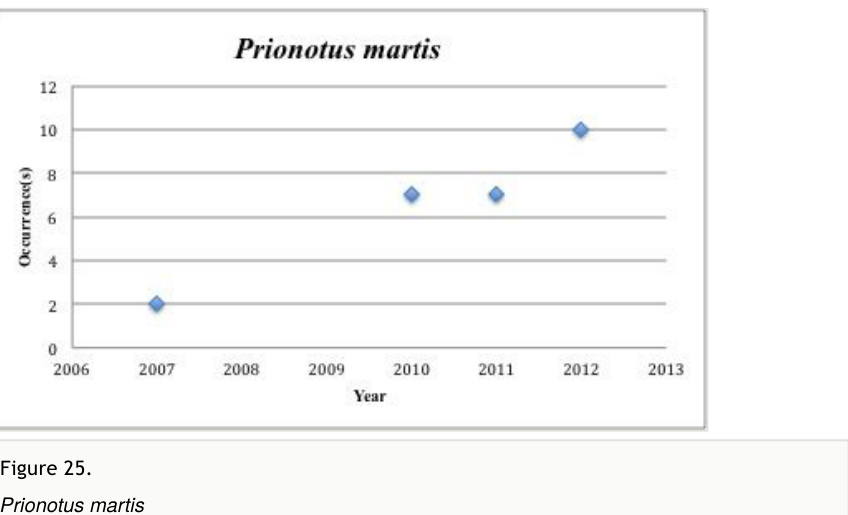
Figure 25. Prionotus